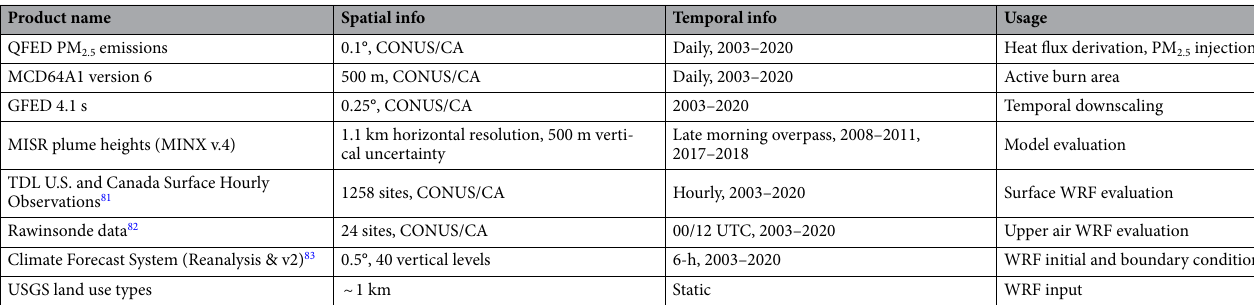
Table 1. A description of the data products used. The spatial and temporal information reflects the regions and years used in this study. Geographic acronyms: Continental United States (CONUS), Canada (CA). *All datasets subset to West of − 100° E